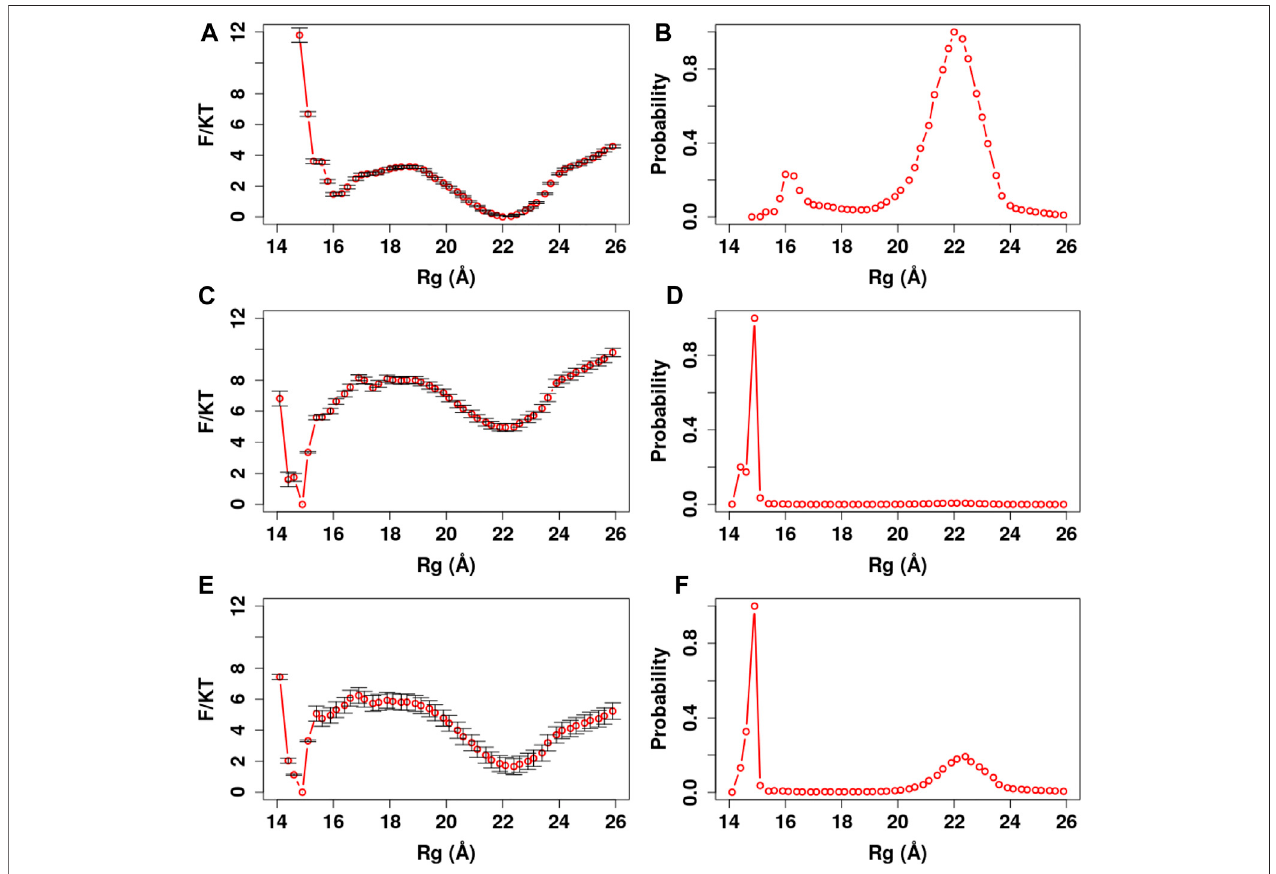
FIGURE8| PMFandRgdistributionoftheCa 2+ -CaMfordifferentCa 2+ models.TheoptimizedmemoryparametersfortheCa 2+ -CaMmodelwereused( λ FM (cid:1) 0 . 1, W others